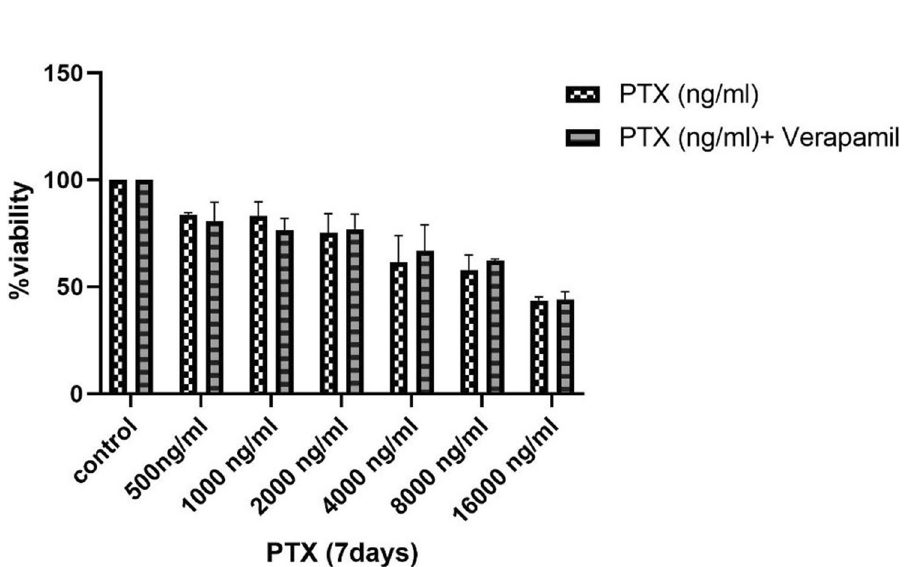
Figure 6. Resistance mechanism of hAECs against PTX. Co-treatment of hAECs (2000 cells) with PTX and verapamil, a P -gp inhibitor, showed that verapamil did not reduce the viability of hAECs after exposure to PTX. * P ≤ 0.05; ** P ≤ 0.01; *** P ≤